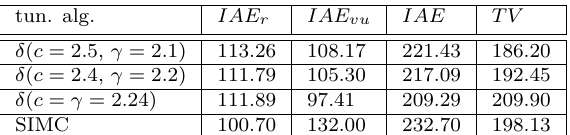
Table 10: Shows the performance indices IAE r , IAE vu , sum IAE and TV (Eq. (43)) for the δ -tuning and the SIMC rule, corresponding to the step responses in Figure 18.